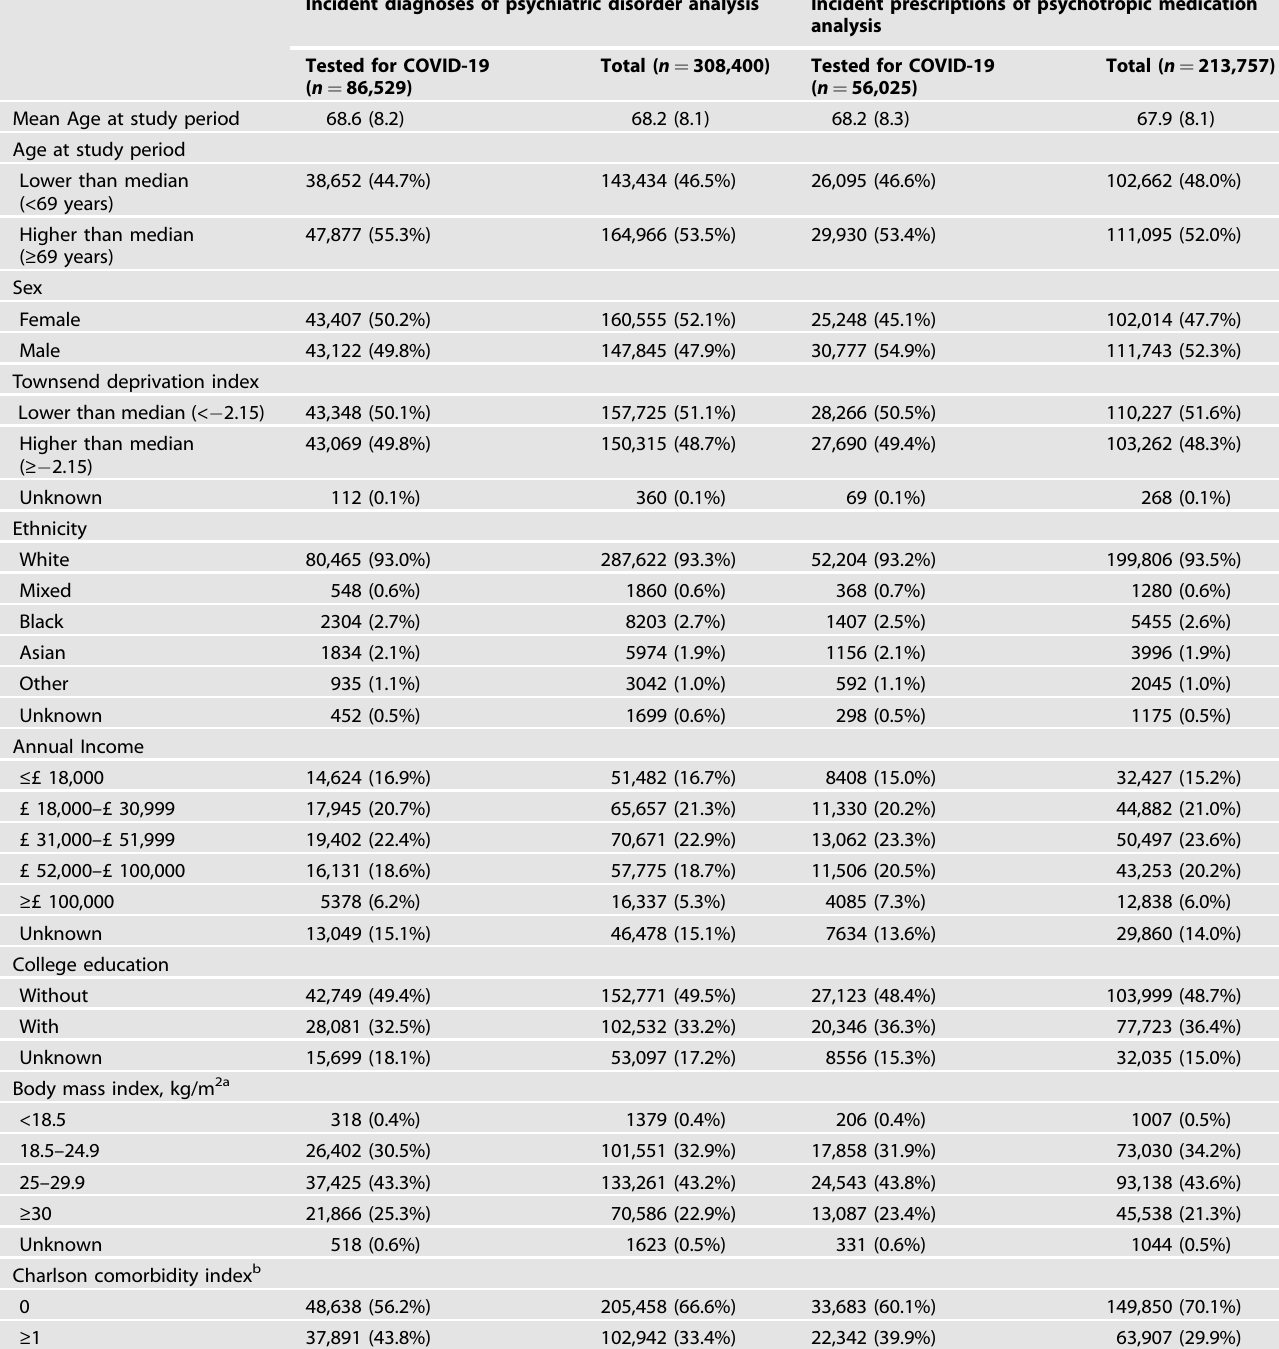
Table 1. Characteristics of the pandemic